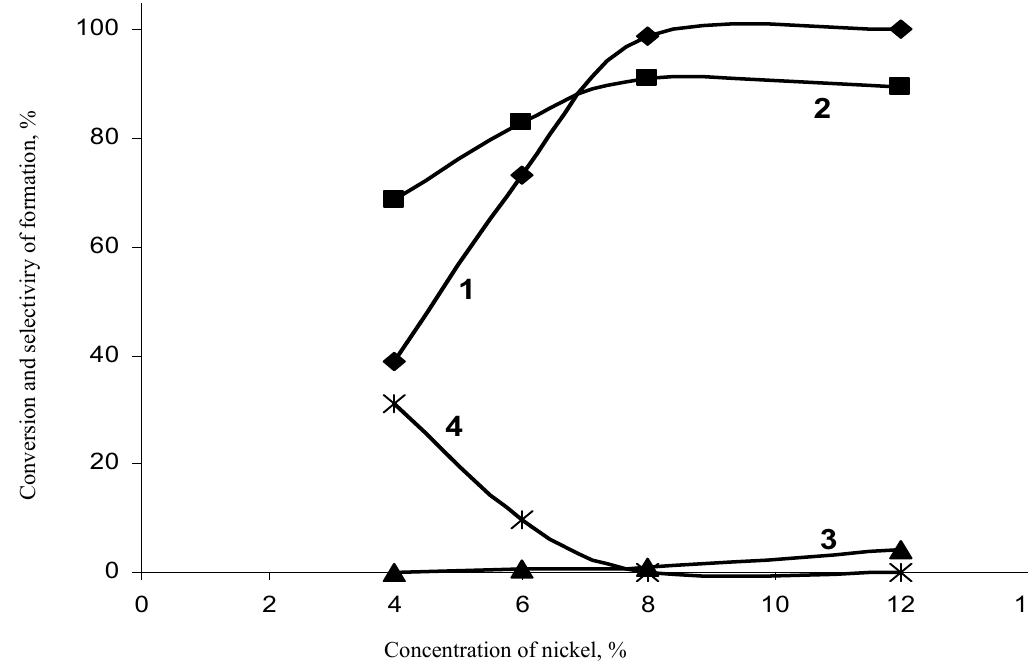
Figure 6. Dependence of the indices of 1,2-dichloroethane hydrodechlorination on a nickel catalyst on nickel concentration of microspheric alumina at 350 ◦ C. 1—conversion of dichloroethane; 2—selectivity of ethylene formation; 3—selectivity of ethane formation; 4—selectivity of vinyl chloride formation.